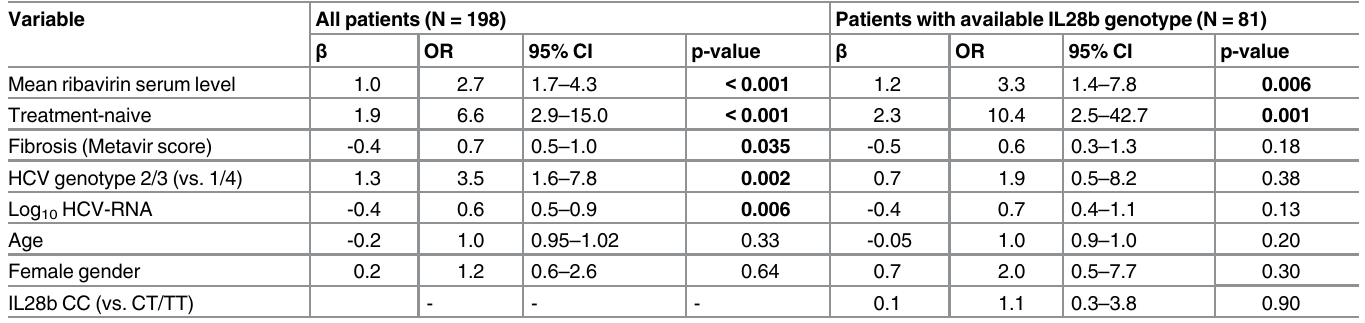
Table 4. Multivariate logistic regression analysis of factors influencing sustained virological response.